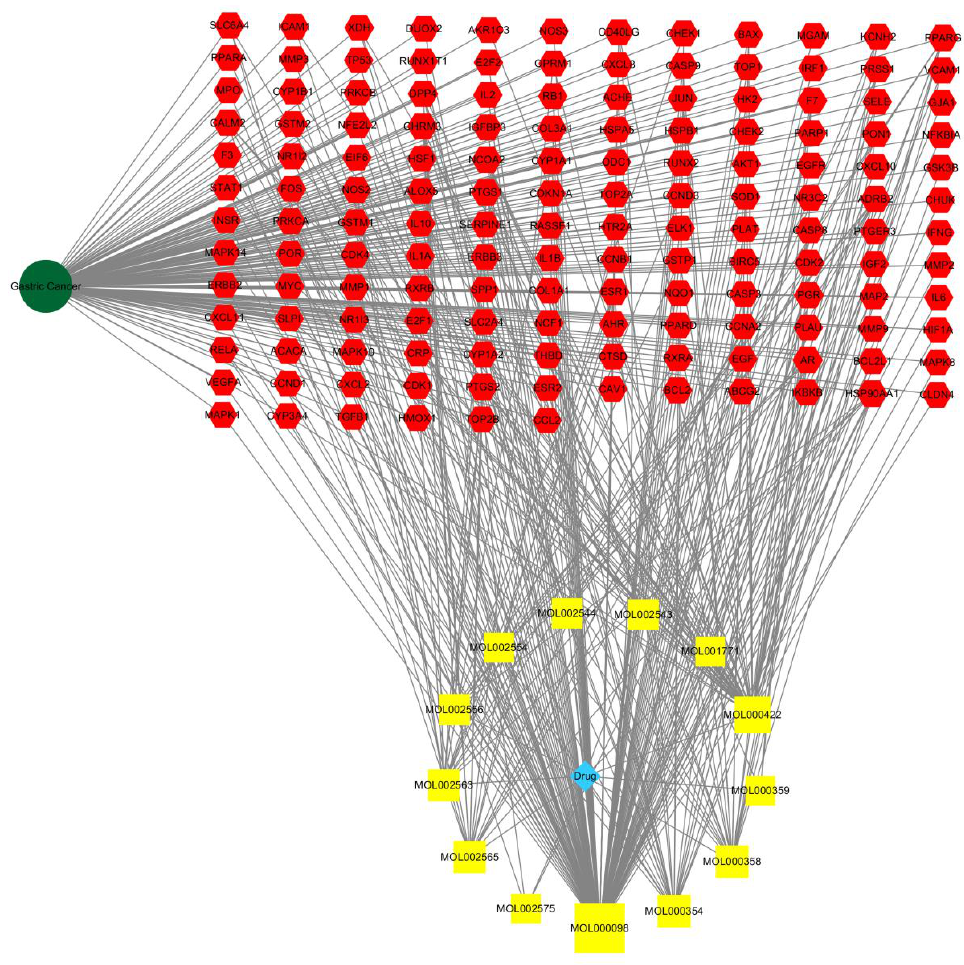
Figure 2. Galangal-component-target-gastric cancer network construction diagram. Blue: Drugs; Yellow: Active Ingredient ID; Green: Gastric Cancer; Red: Interactive target. Edge: The degree of association of the disease target with the drug component.